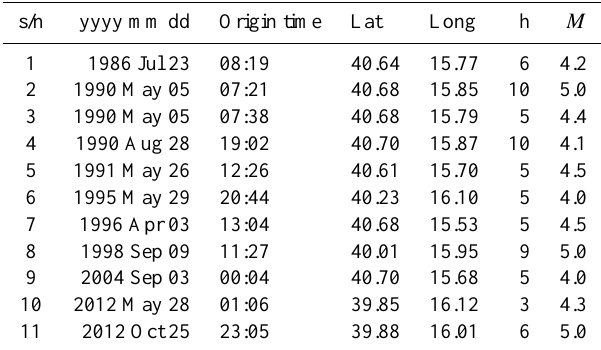
Table 1. Strong earthquakes, M w ≥ 5 . 6, in the time